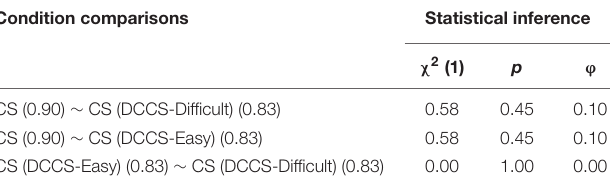
TABLE 4 | Comparison of different conditions involving violation of mass balance among participants. Condition